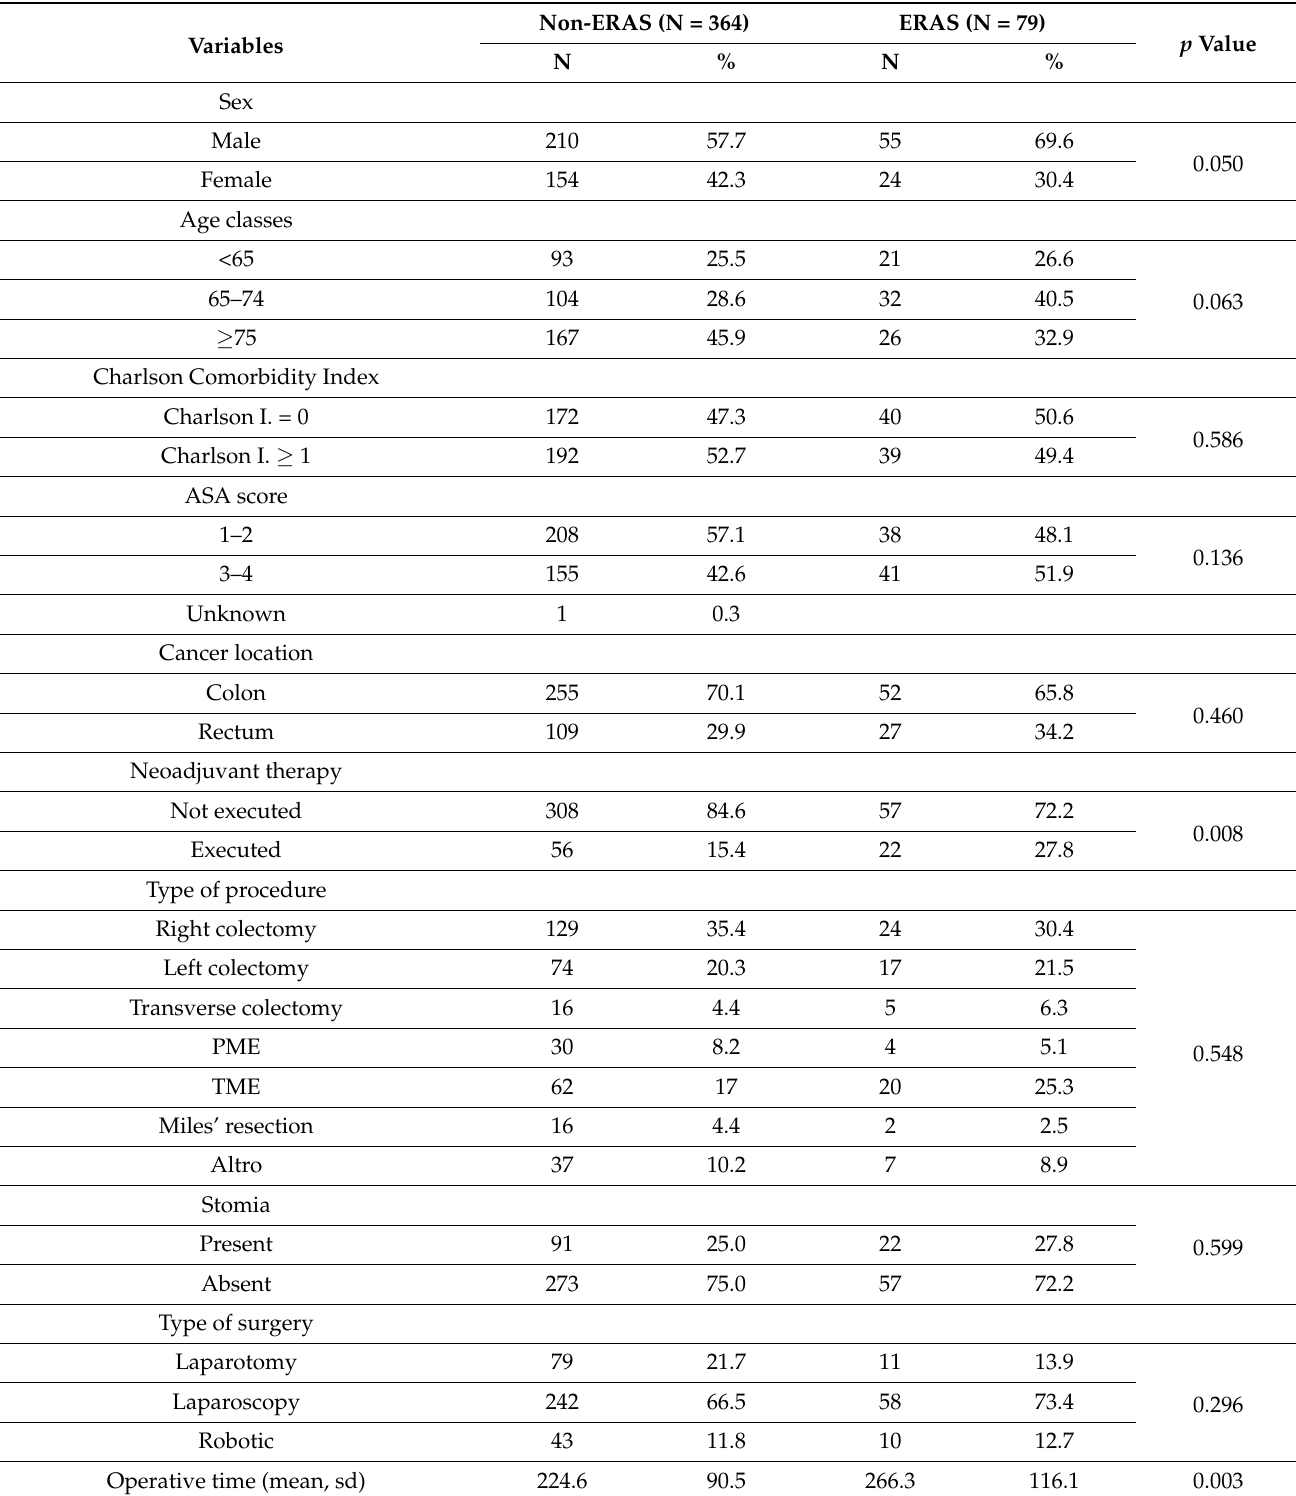
Table 1. Patients’ characteristics at baseline by type of center (non-ERAS and